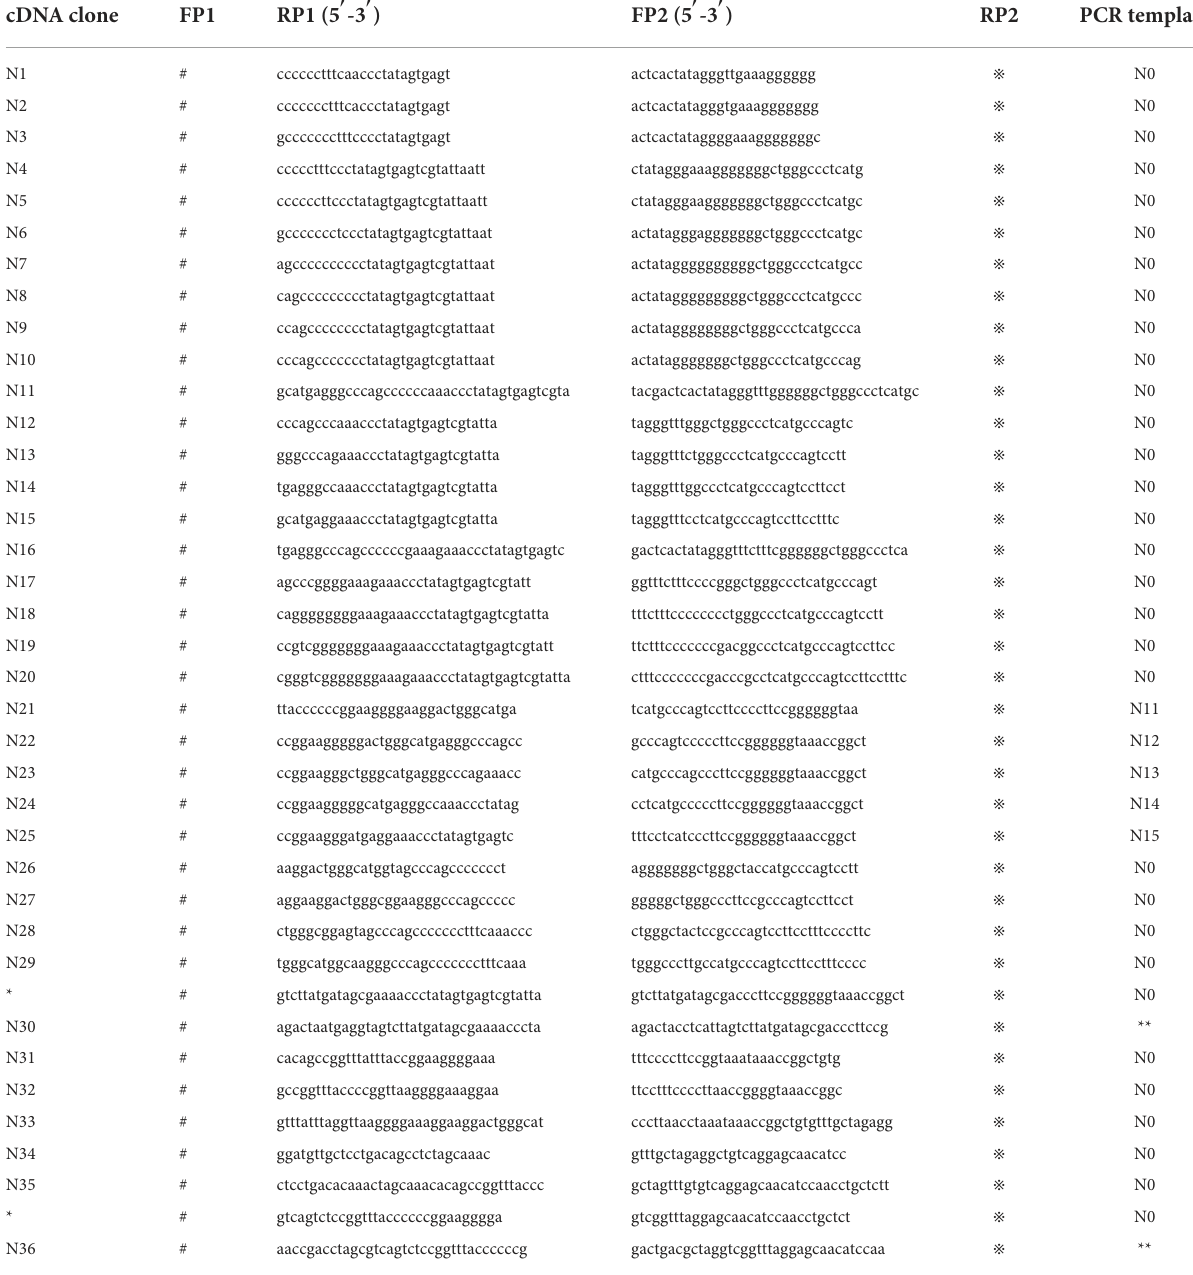
TABLE 1 Primers used to construct 5 ′ -end-modifying SVA cDNA clones by OE-PCR. cDNA